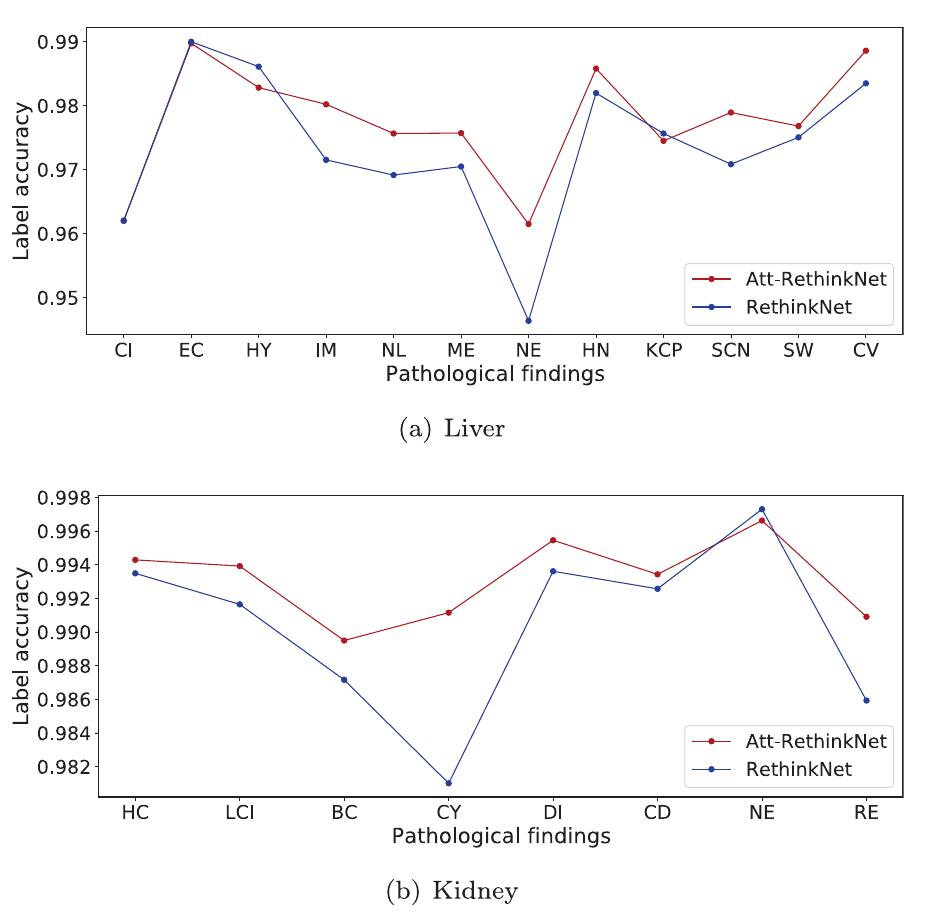
Fig 7. The ACC lab of deep learning experiments in liver data (a) and kidney data